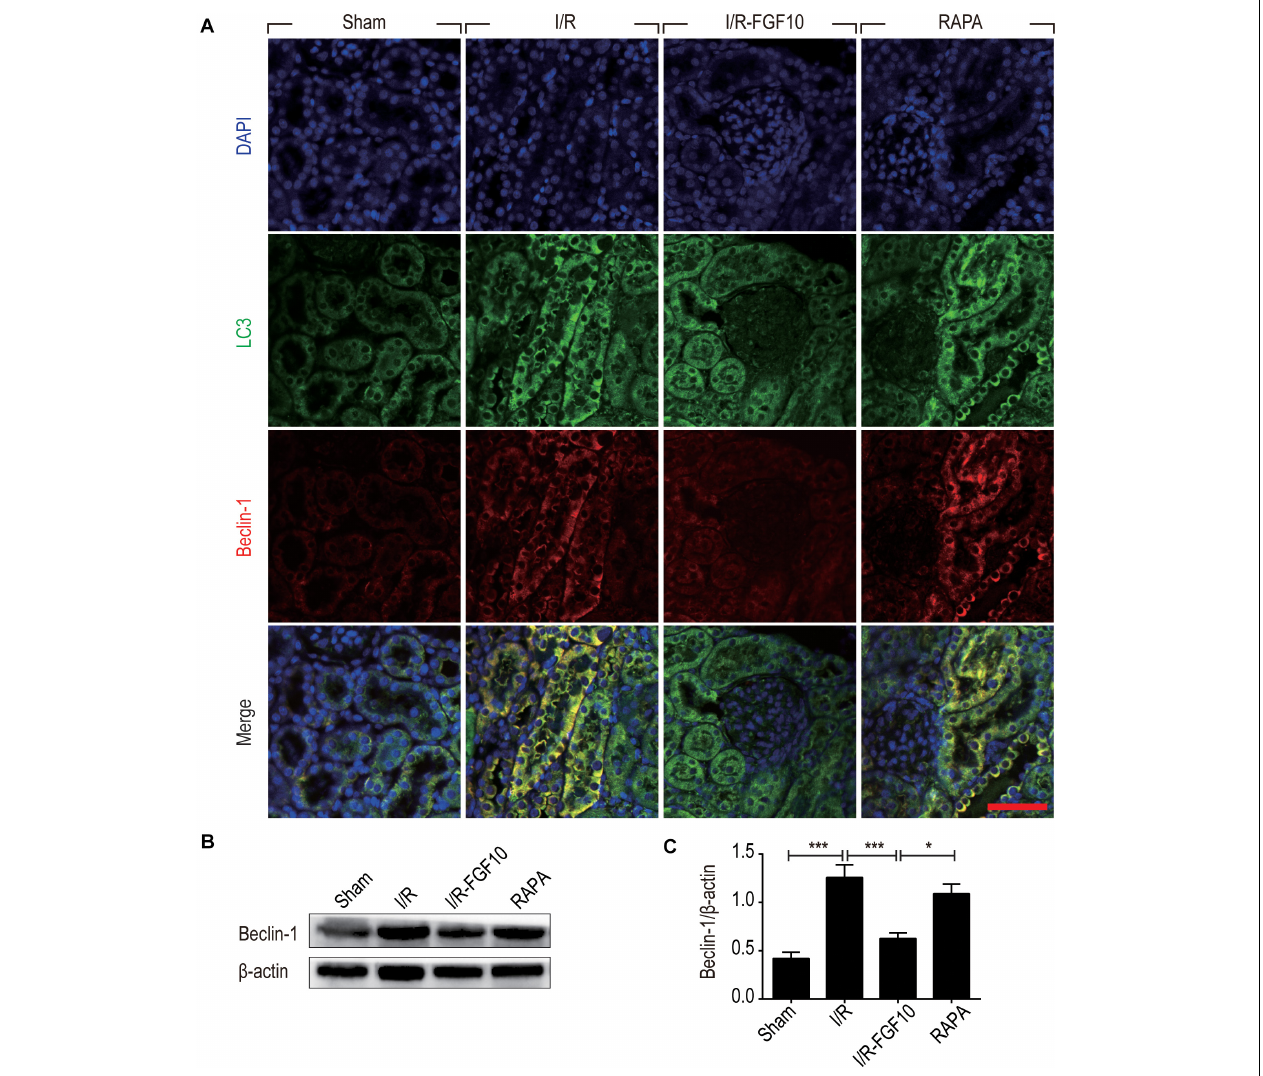
FIGURE 5 | FGF10 reduces the expression of Beclin-1. (A) Immunofluorescence staining and confocal images for LC3 (Green) and Beclin-1 (red) at 2 days after reperfusion. Nuclei were labeled with DAPI (blue). Scale bars = 50 µ m. (B) Representative western blotting result for Beclin-1 expression. (C) Optical density analysis of protein bands. Data are presented as the mean ± SEM ( n = 5). ∗ P < 0.05, ∗∗∗ P <